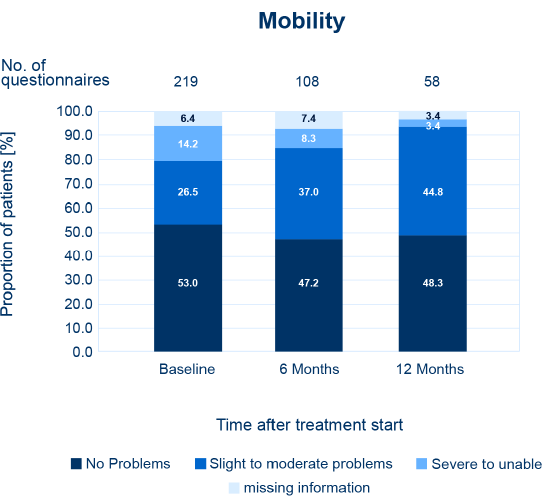
Figure 3. Quality of life under pazopanib for the “mobility” dimension at baseline and after 6 and 12 months of treatment. Percentages refer to the number of returned questionnaires. For other dimensions, see Figures